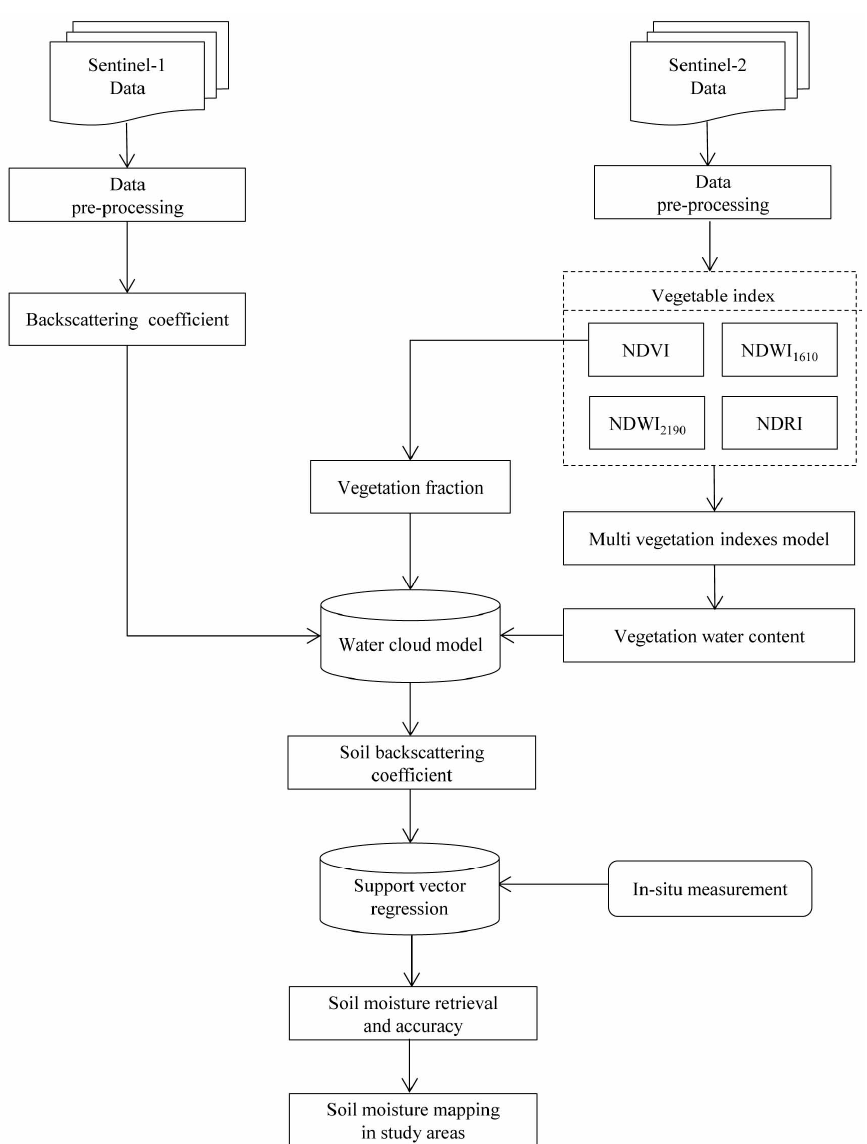
Figure 3. Flowchart of the soil moisture retrieval process based on Sentinel ‐ 1 and Sentinel ‐ 2 data.